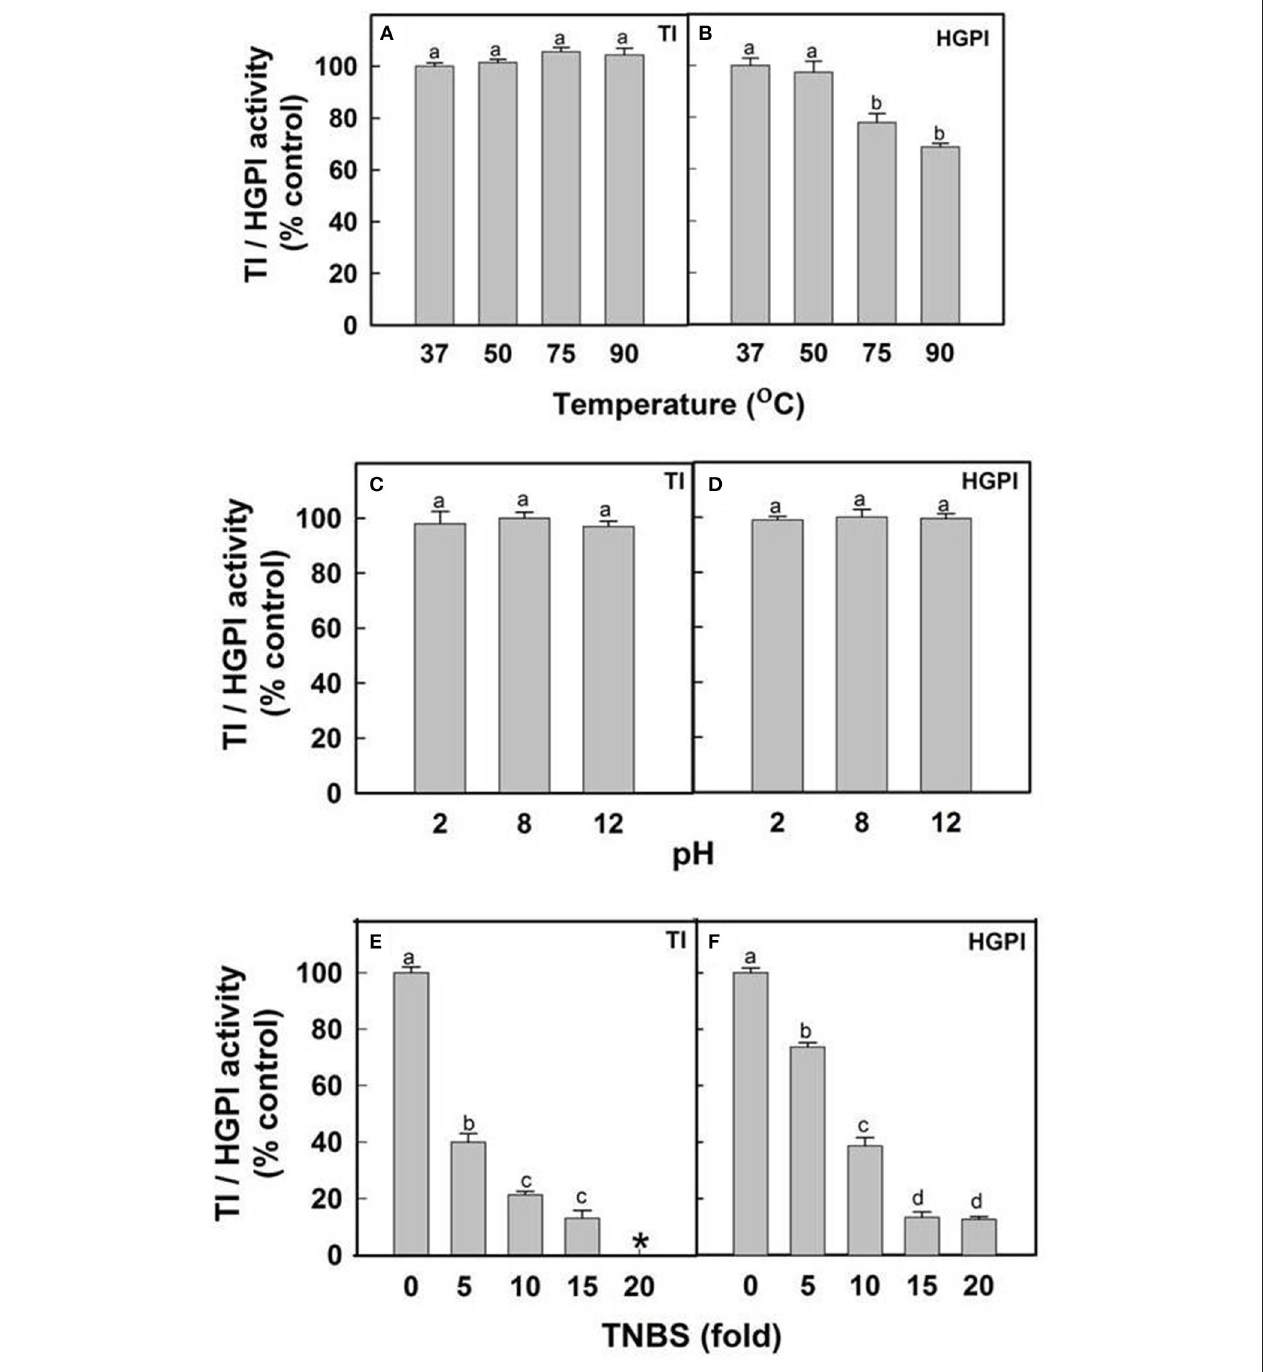
FIGURE 6 | Effect of temperature, pH and lysine modification on HGPI activity of CpPI 63. Stability of TI/HGPI activities of CpPI 63 against (A) bovine pancreatic trypsin and (B) HGPs, respectively, after incubating for 30min at indicated temperatures before performing the respective assays; Stability of TI/HGPI activities of CpPI 63 against (C) bovine pancreatic trypsin and (D) HGPs, respectively, after incubating with respective pH buffers at 37 ◦ C for 1h before performing the assays; Loss in the TI/HGPI activities of CpPI 63 against (E) bovine pancreatic trypsin and (F) HGPs, respectively, after biochemical modification of lysine residues in it using TNBS as described in materials and methods. *indicate complete loss of inhibitory activity against trypsin. Statistics were performed as described in Figure 4 . Different lowercase alphabetical letters indicate statistically significant differences ( P < 0.05).